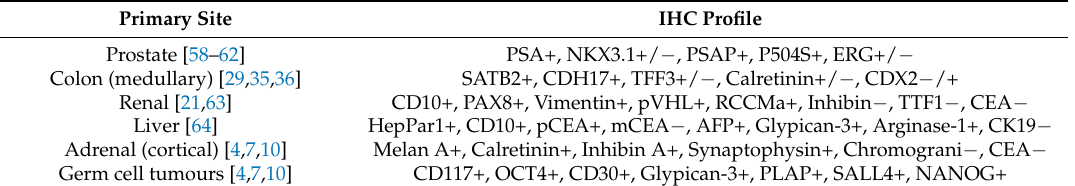
Table 5. IHC tumour staining patterns in the differential diagnosis of CUPs expressing CK7 − /CK20 −